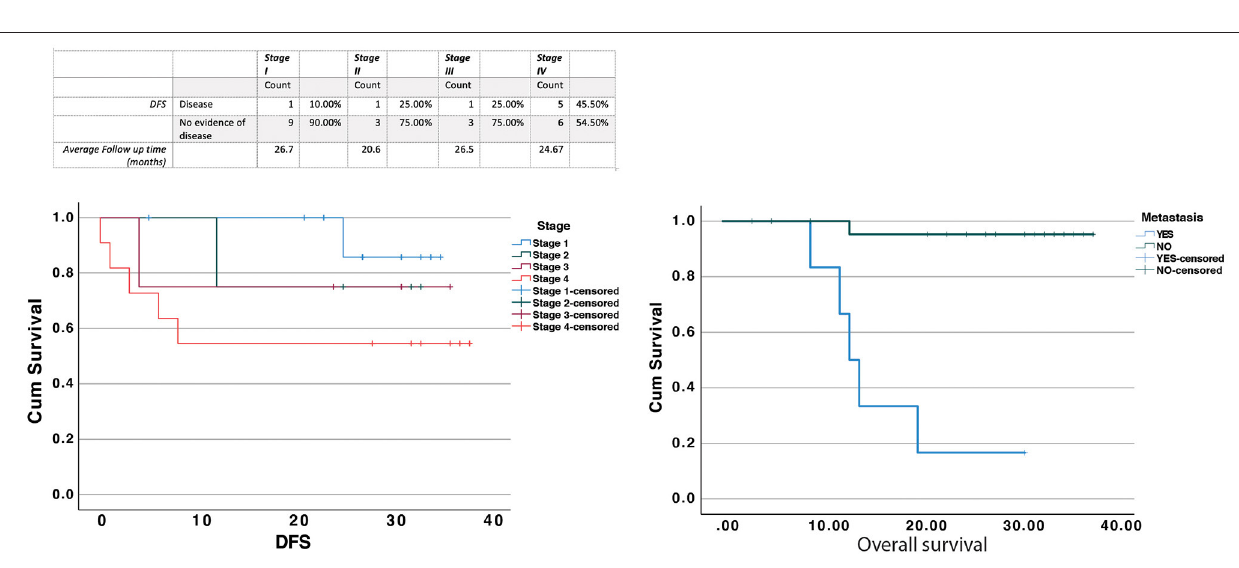
FIGURE 5 | Patient outcomes were determined based on the review of the electronic patient records at Sunnybrook hospital. Patients that had no follow up after diagnosis were considered as lost to follow up and were not included in the table above. The results were analyzed using the Log Rank test for Stage (Log Rank test, p = 0.309) and presence of metastasis (Log Rank test, p =